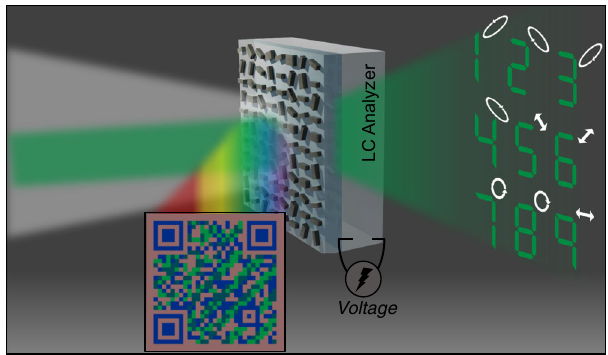
Fig. 1 Illustration of vectorial holographic color prints using a pixelated metasurface and liquid crystal (LC) analyzer. Under ambient white light, the device displays a two-colored QR code image. On the other hand, with laser illumination the vectorial hologram images can be rendered. With an aid of LC analyzer, electrically tunable vectorial holographic color prints are